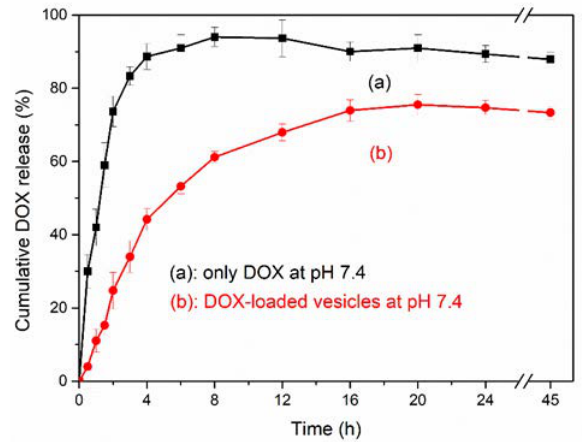
Figure 4. DOX release profiles of ( a ) free DOX and ( b ) DOX-loaded vesicles in 0.01 M tris bu ff er at pH 7.4.